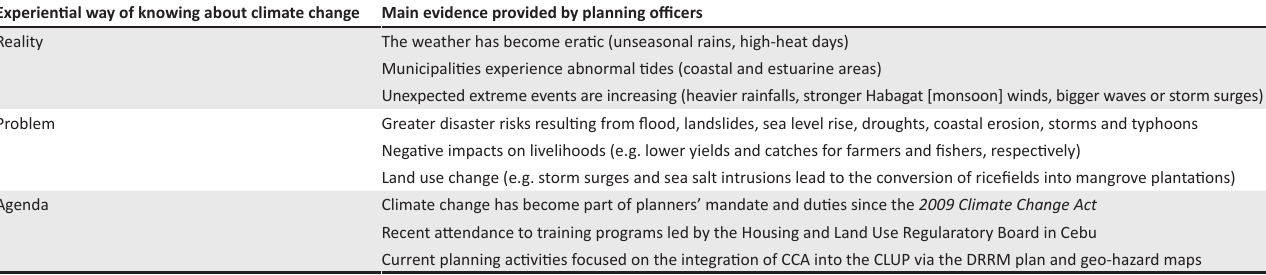
TABLE 1: Summary of planners’ experiential ways of knowing about climate change within the coastal municipalities of Bohol. Experiential way of knowing about climate change Main evidence provided by planning officers Reality Municipalities experience abnormal tides (coastal and estuarine areas) Problem